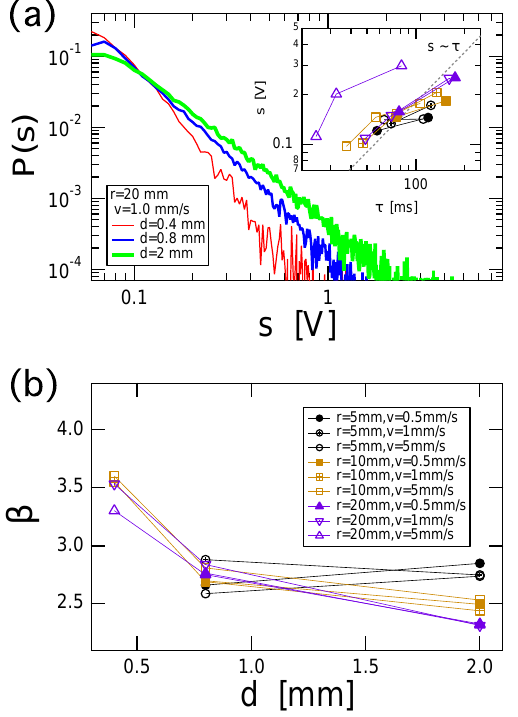
Fig. 4. Size distribution of AE events. (a) Normalized AE frequency P(s) shows power law form, P(s) ∼ s − β . The inset shows the re- lation s ∼ τ , where τ is the decay timescale of AE events. (b) Ex- perimental conditions dependence of the exponent β . The exponent β depends on grain size d .